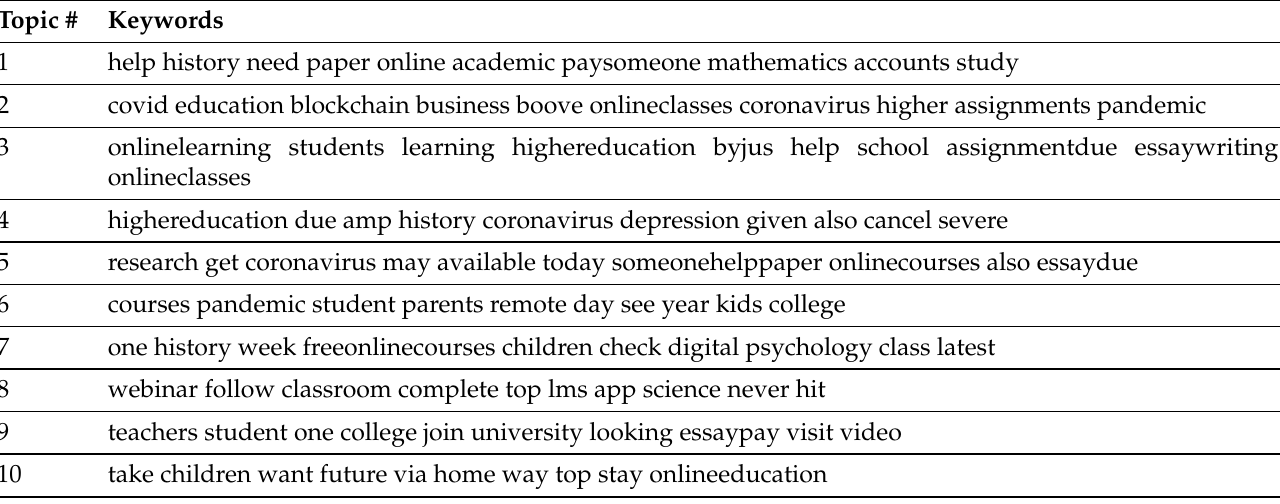
Table 20. Topic modeling with LSA for positive tweets.